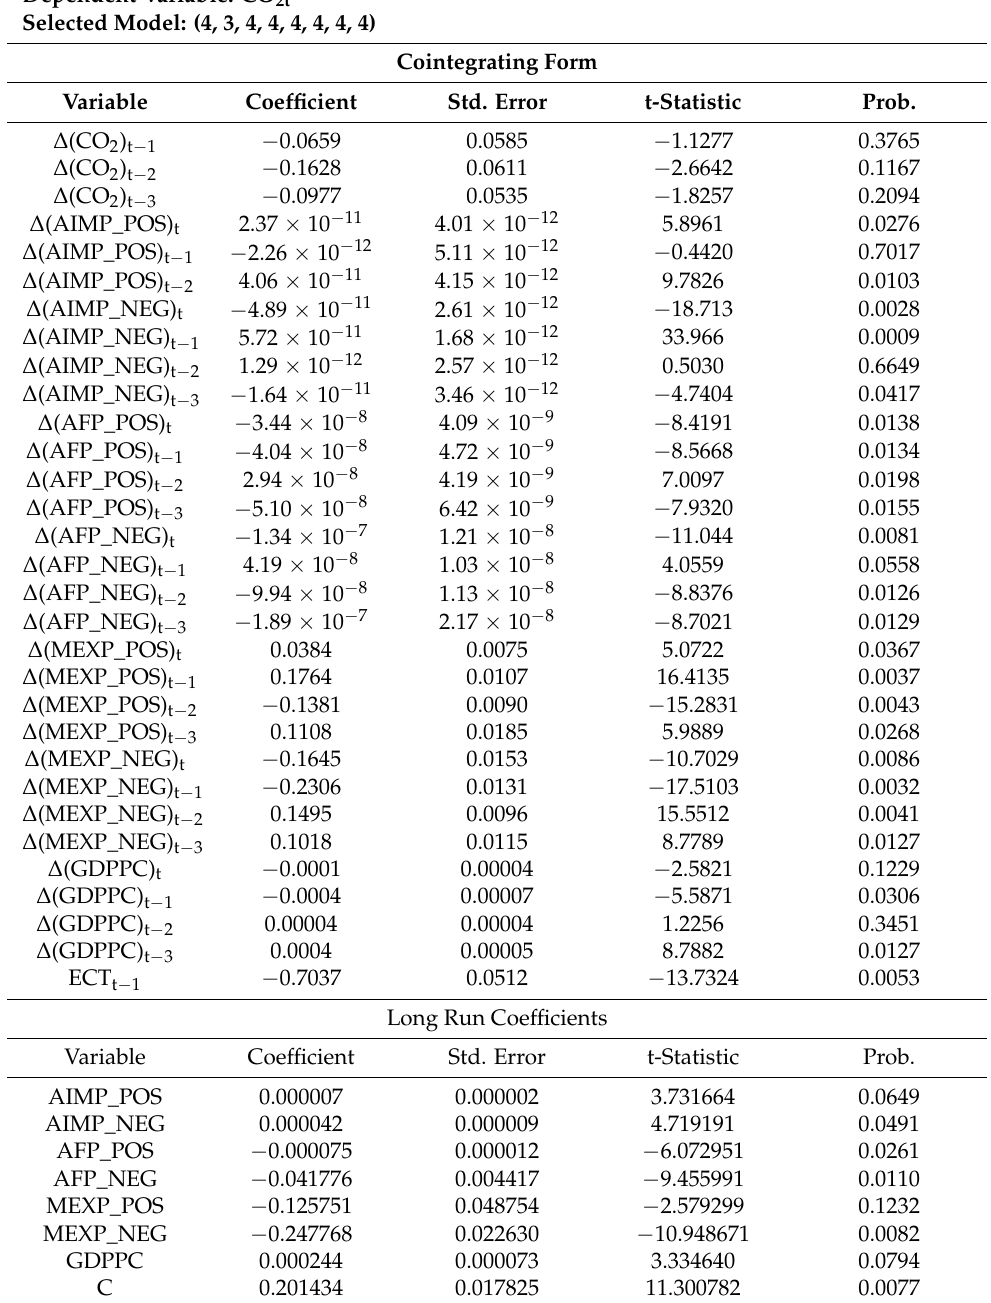
Table 5. NARDL short- and long run